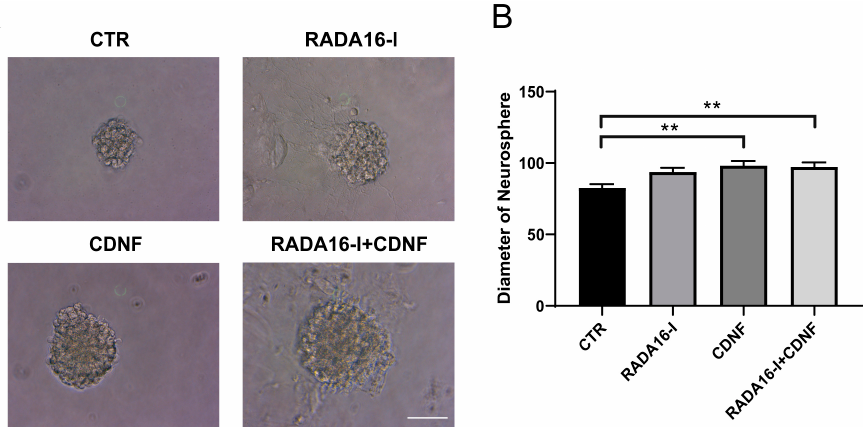
Figure 1. CDNF promoted the proliferation of cultured NSCs. ( A ) Light-microscopic images of cultured NSCs cultured in neurosphere on the fifth day. Scale bar = 25 µm. ( B ) The diameter of neurospheres in each group was quantified. Values represent the mean ± SEM, ** p < 0.01 according to ANOVA followed by LSD post hoc analysis.